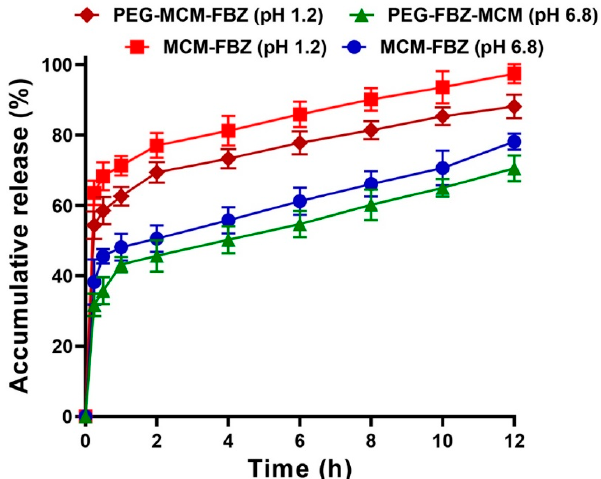
Figure 4. Pattern of FBZ release from MCM ‐ FBZ and PEG ‐ MCM ‐ FBZ NPs, measured at pH 1.2